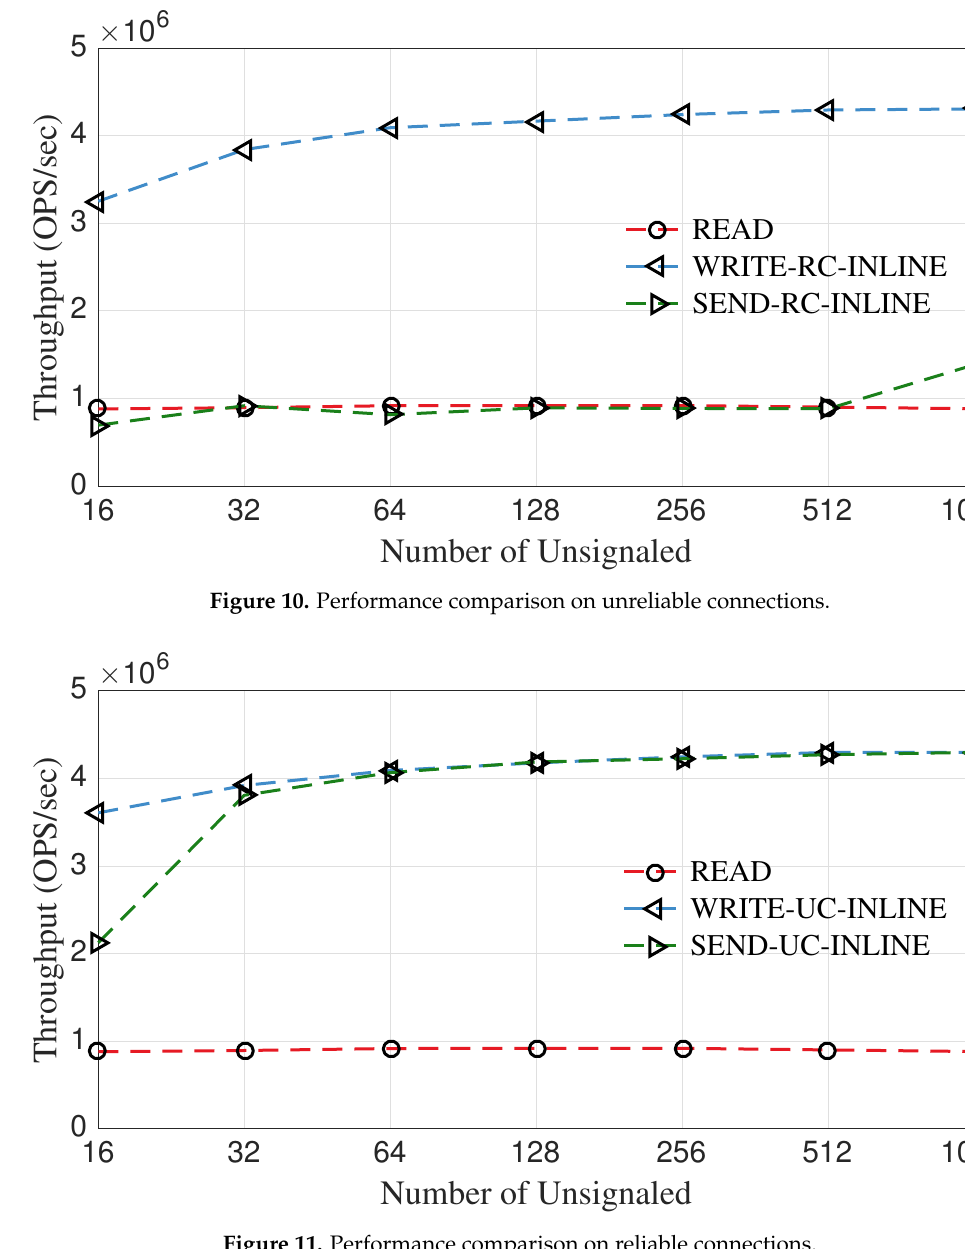
Figure 11. Performance comparison on reliable